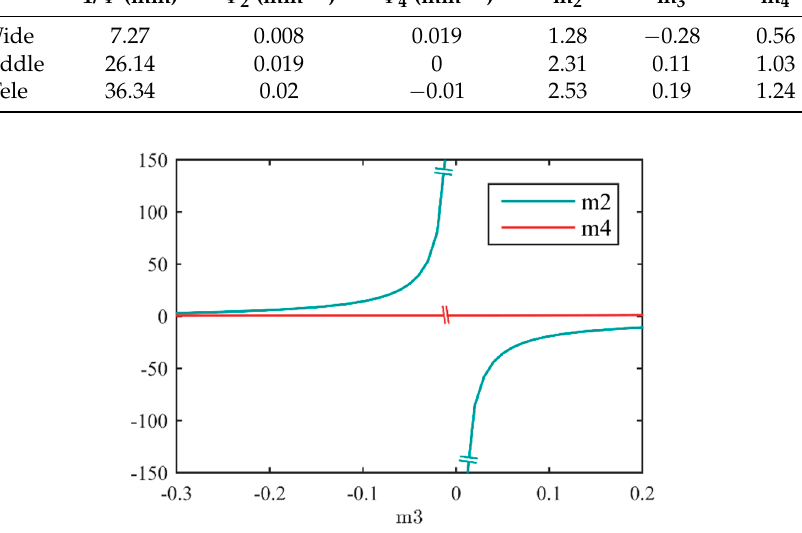
Figure 2. Relationship between m 2 , m 3 , and m 4 . A larger derivative of m 3 can be found near the breakpoint since the sign of m 3 is changeable.